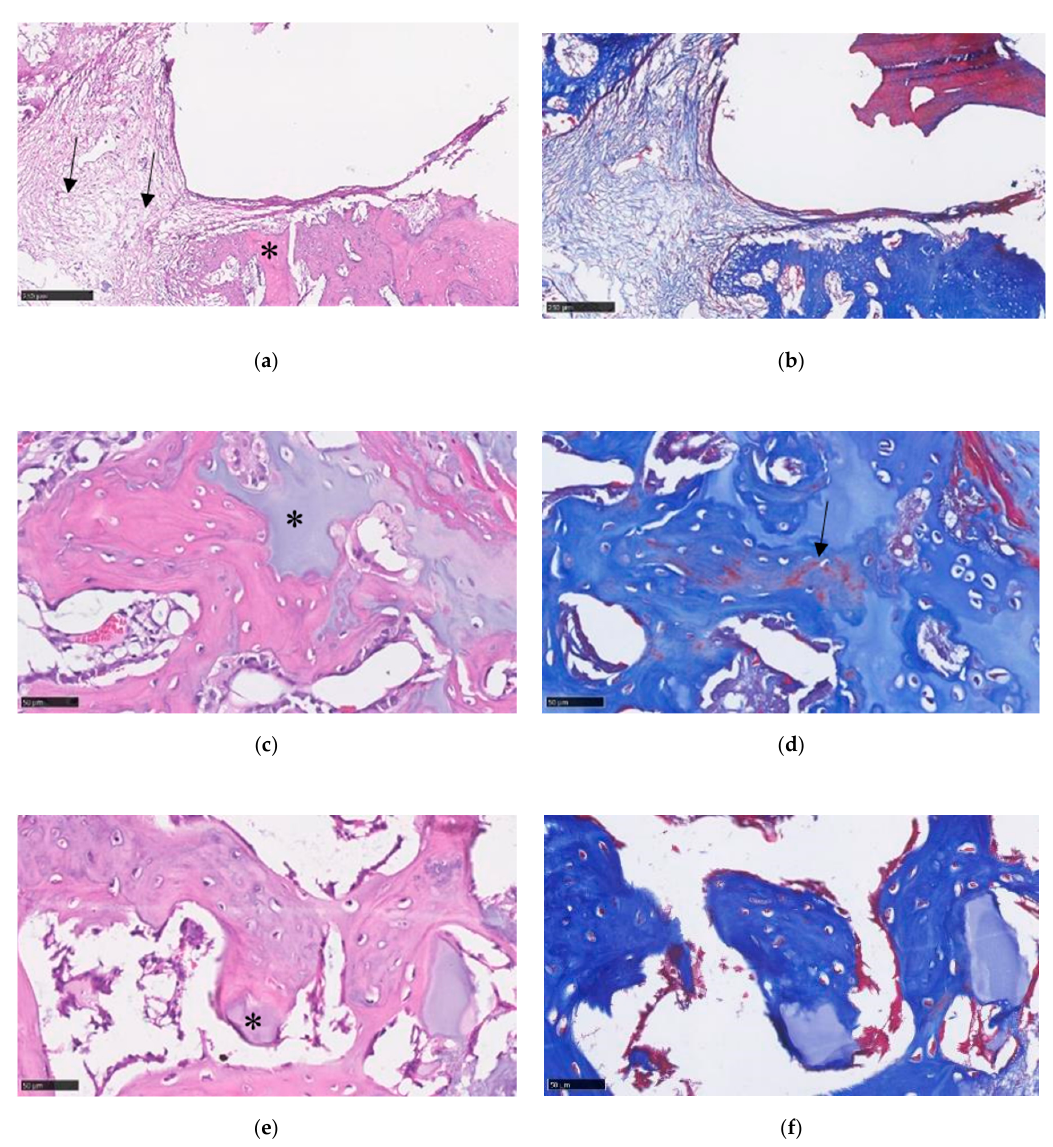
Figure 12. ( a ) Histology section under 10× magnification view showed a large bone defect and normal bone structure (asterisk) in the control group under hematoxylin and eosin (H&E) staining. Some fibrotic tissue (black arrows) was also found in the bone defect. ( b ) No new bone formation was noted under Masson’s trichrome (MT) stain in the control group. ( c ) Under 40× magnification view of the composite without SDF-1 group, residual material (asterisk) can be seen. ( d ) New bone formation (black arrow) can be found under MT stain in the group without SDF-1. ( e ) In the 100 ng/mL SDF-1 group, smaller residual material (asterisk) was shown to be well integrated into the normal bone structure under H&E stain. ( f ) Histology section of SDF-1 group under MT stain.